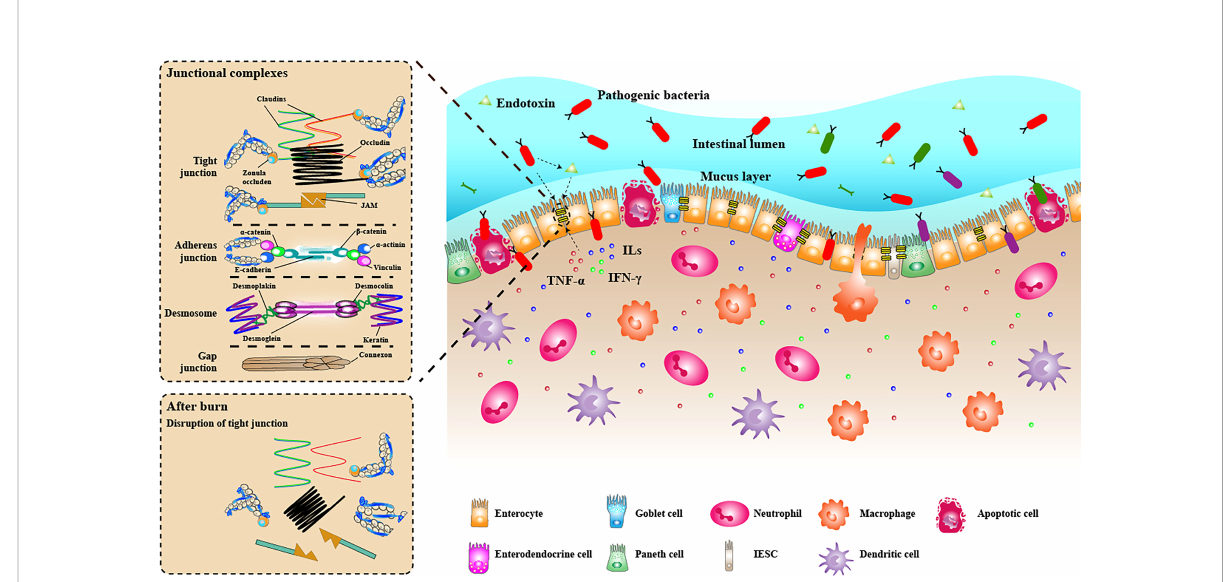
FIGURE 3 The intestinal mucosal barrier under the condition of burn injury. The intestinal mucosal barrier was seriously damaged under burn conditions. The junction structure between intestinal epithelial cells was destroyed, some intestinal epithelial cells were apoptotic, and the mechanical barrier lost its integrity. The mucus layer becomes thinner or even disappears. Many in fl ammatory cell (neutrophils, macrophages, dendritic cells) in fi ltrated the lamina propria, releasing proin fl ammatory cytokines (TNF- a , ILs, IFN- g ), further destroying the intestinal barrier. The diversity of bacteria in the intestinal lumen decreased signi fi cantly, while pathogenic bacteria had excessive growth. Some bacteria can penetrate the broken intestinal barrier, invade the lamina propria and carry endotoxin translocation into the